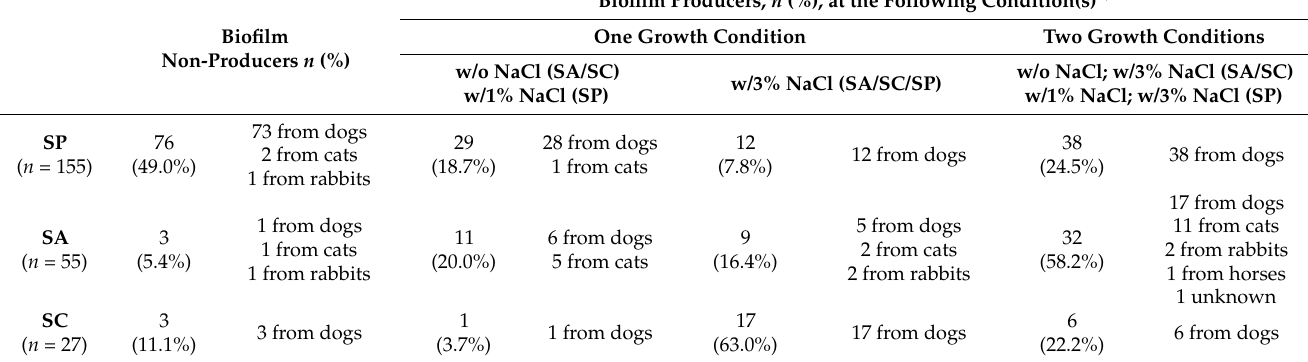
Table 1. Distribution of biofilm production phenotype for the S. pseudintermedius (SP), S. aureus (SA) and S. coagulans (SC) strains in the different growth conditions tested. The proportion of biofilm producers and non-producers according to animal host is also detailed for each CoPS. A strain was considered a biofilm producer if it showed weak, moderate or strong production of biofilm in either one or both conditions tested. A strain was considered a non-producer of biofilm if categorized as non-producer in the two conditions